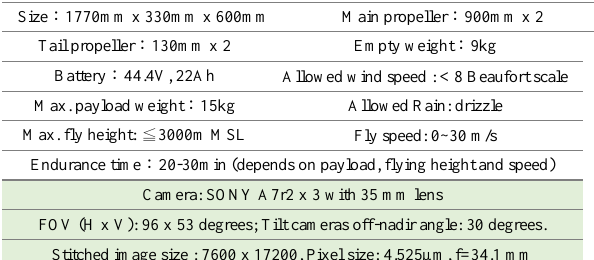
Figure 2. The adopted unmanned helicopter and three-camera imaging system. Table 1. The specification of the used UAV and camera.